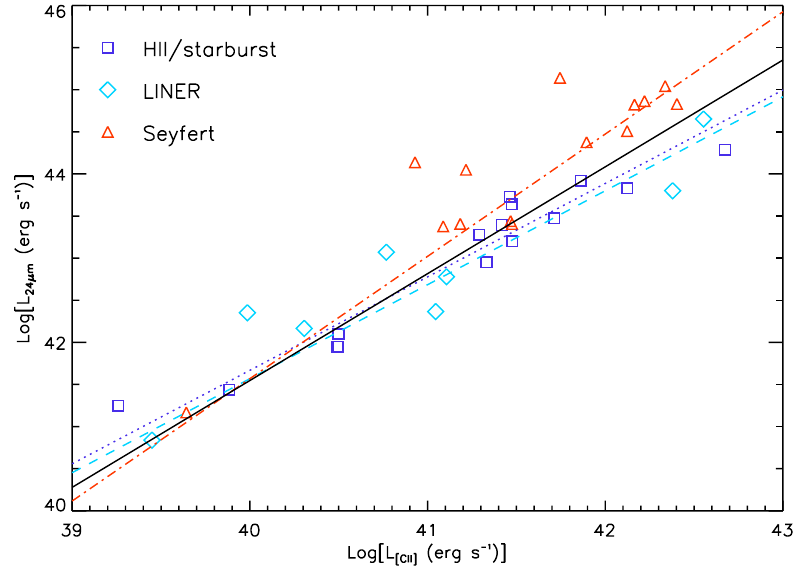
Fig. 1. L [CII] as a function of L 24 (cid:22) m for the three subsamples. The best (cid:12)tting lines through the data points are indicated: the dotted, dashed and dashed-dotted lines are for the H II region/starburst, LINER and Seyfert subsamples, respectively. The mean trend for the complete sample is represented by a solid